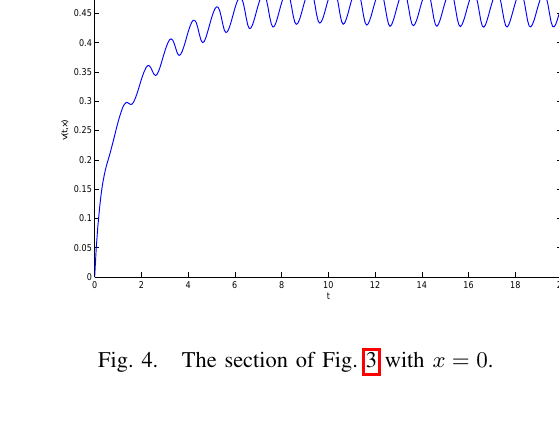
Fig. 4. The section of Fig. 3 with x = 0